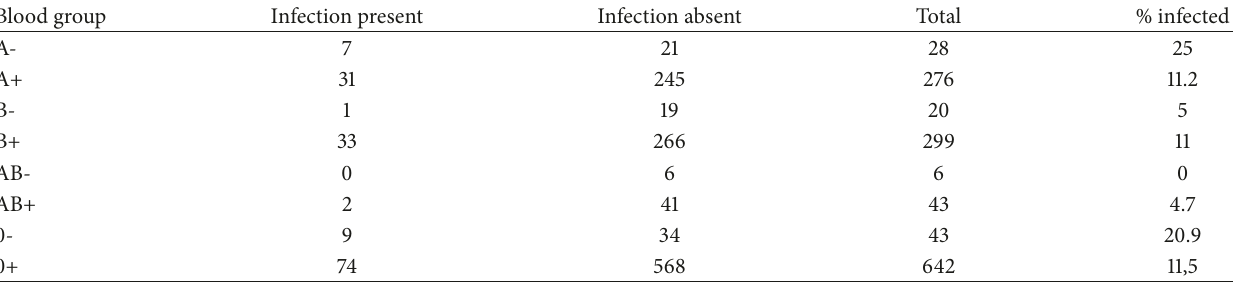
Table 2: Relationship between blood infection and blood